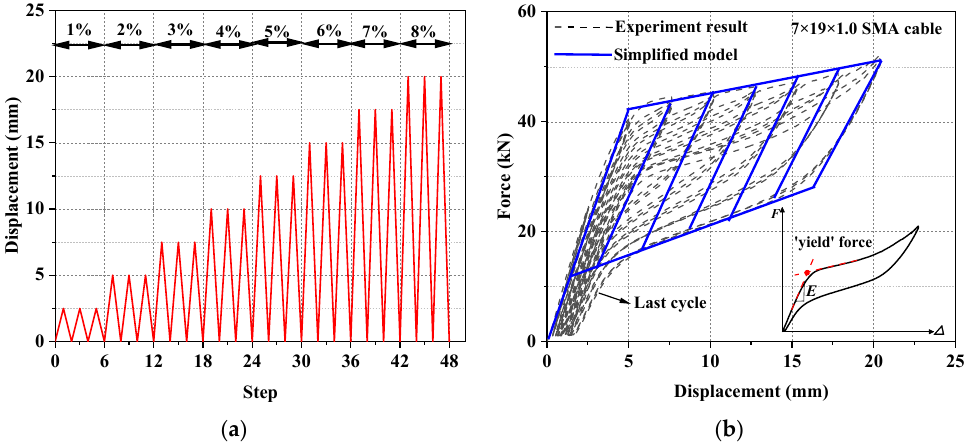
Figure 6. Test of SMA cable specimen: ( a ) loading protocol and ( b ) test results.